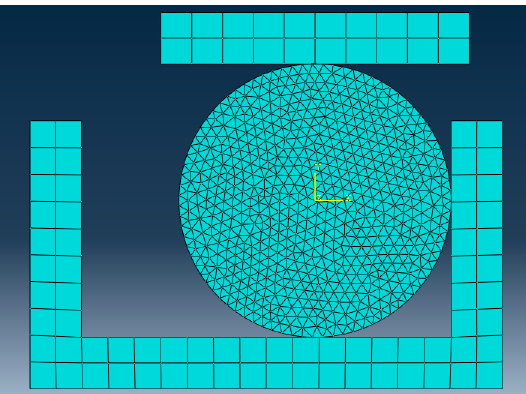
Figure 3. Finite element model of the O-ring.